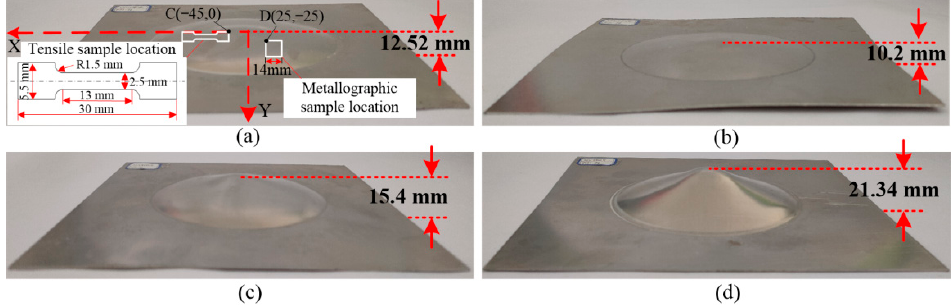
Figure 6. Experimental results for different forming temperatures at a voltage of 5 kV: ( a ) 25 °C; ( b ) 200 °C; ( c ) 300 °C; ( d ) 400 °C.